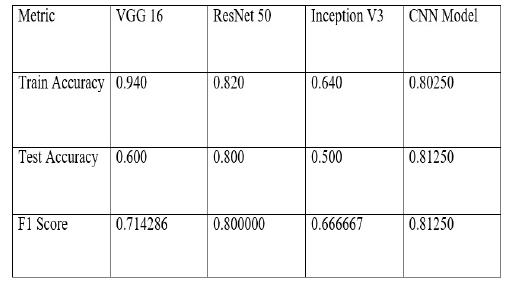
Figure 6. Performance of VGG16, ResNet 50, Inception V3 and CNN